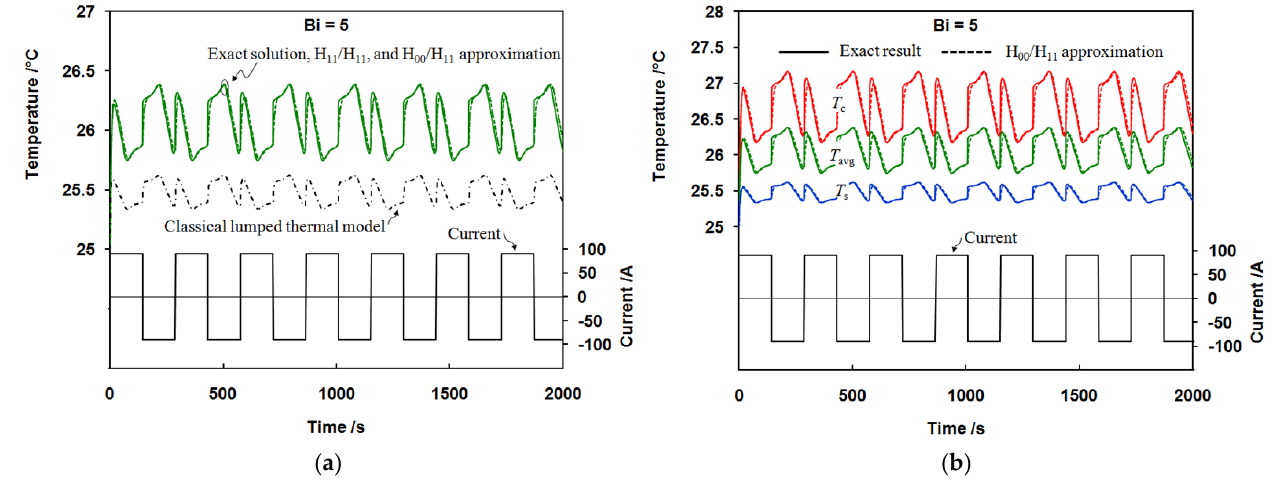
Figure 8. Application and validation of improved LC thermal model: ( a ) The average temperatures ( T avg ) from the analytical result and the improved LC model for a stepwise duty cycle and Bi = 5. ( b ) Prediction of core, skin (surface), and average temperatures for this cycle. Reprinted with permission from [38]. Copyright 2013 Elsevier.